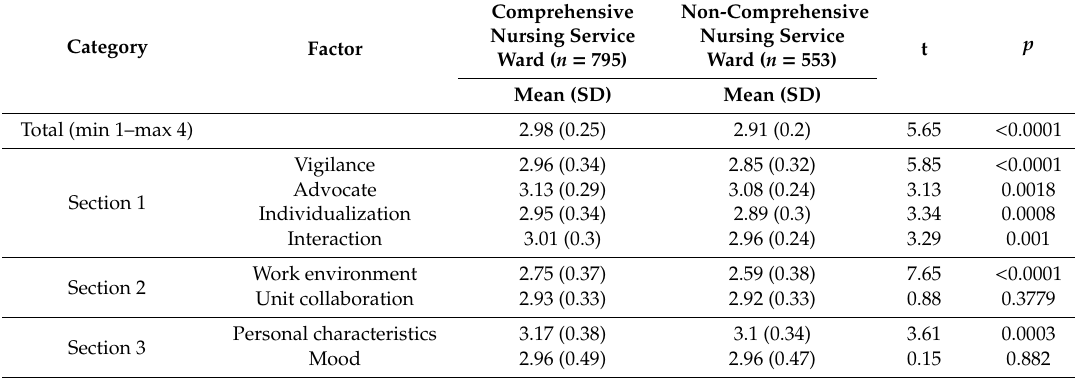
Table 2. Scores on Nurses’ Assessment of Quality Scale (Acute Care Version, NAQS-ACV) ( n = 1348).